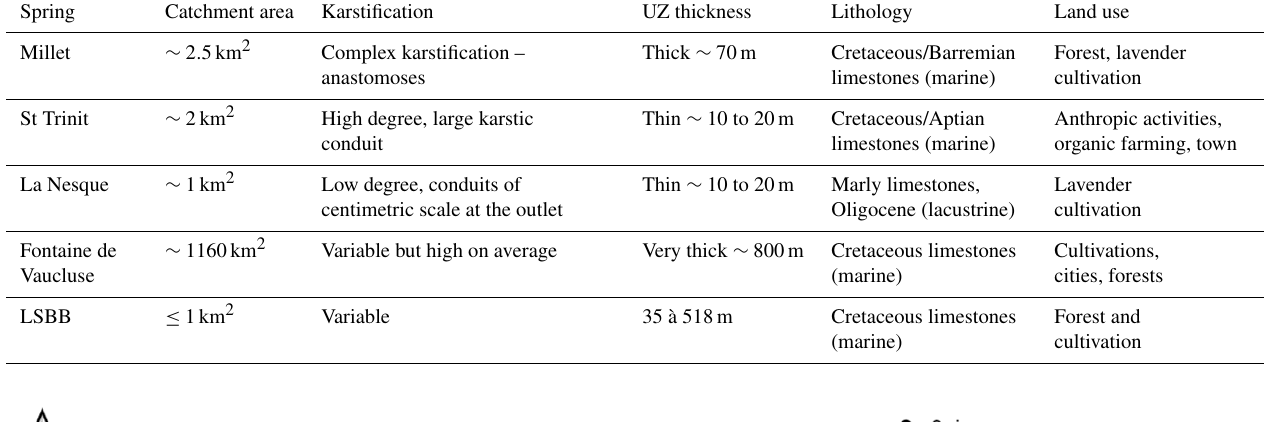
Table 1. Main characteristics of monitored flow points from Batiot (2002), Blondel (2008), Emblanch et al. (1998), Lastennet (1994), Ollivier (2019), and field observations. UZ is the unsaturated zone.